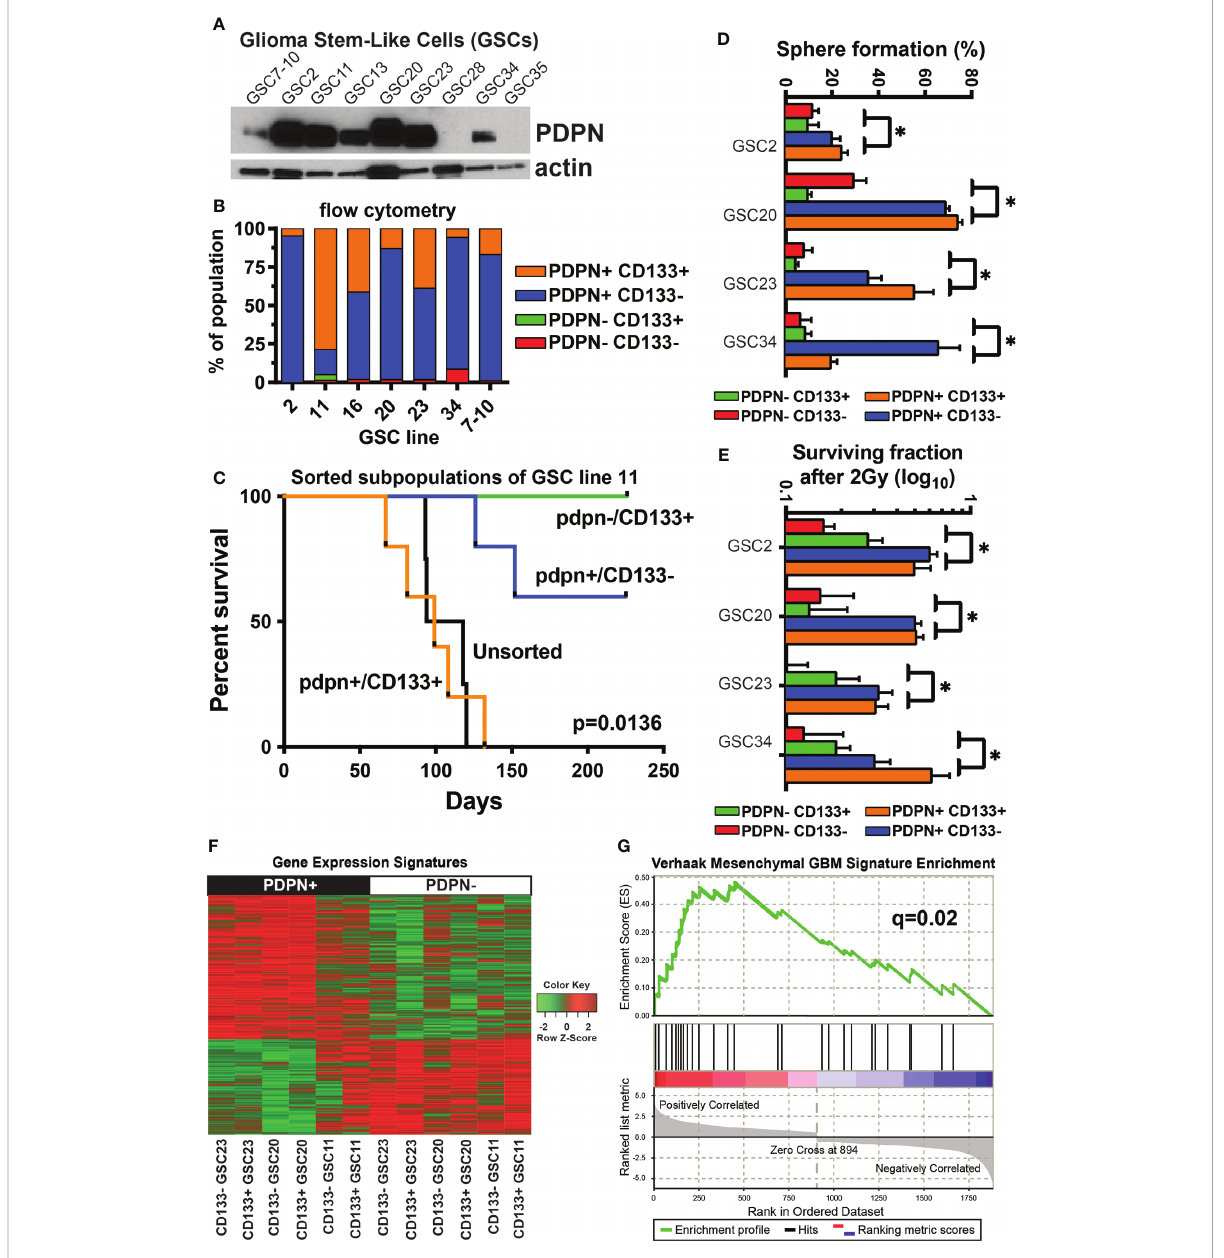
FIGURE 2 PDPN+ glioma-stem-like cells form aggressive tumors in vivo and mark a stem-like radioresistant subpopulation of cells. (A) PDPN protein is expressed in seven of the nine GSC lines shown. (B) Flow cytometry of GSCs shows PDPN expression is pervasive and more prominent in these GSCs. (C) Kaplan – Meier survival analysis of GSC11 PDPN − /CD133+, PDPN+/CD133+, and PDPN+/CD133 − FACS-sorted subpopulations orthotopically injected into the brains of immunocompromised mice reveal that mice harboring tumors from CD133+/PDPN+ cells had a median survival of 99 days (n=5), while mice that received CD133+/PDPN − cells did not succumb to tumor formation (n=3) (p=0.0136, log-rank test). (D) PDPN+ FACS-sorted subpopulations have a higher sphere formation ability (*p<0.005, multiple t-tests, PDPN+ vs . PDPN − groups). (E) PDPN+ FACS-sorted subpopulations have a higher surviving fraction of cells after 2 Gy of radiation (*p<0.005, multiple t-tests, PDPN+ vs . PDPN − groups). (F) Transcriptome analysis revealed distinct gene expression signatures in PDPN+ and PDPN − sorted GSCs (three different cell lines). (G) GSEA of differentially expressed genes (p<0.05) demonstrated signi fi cant enrichment of the mesenchymal subtype signature (NES=2.04, q=0.02) in PDPN+